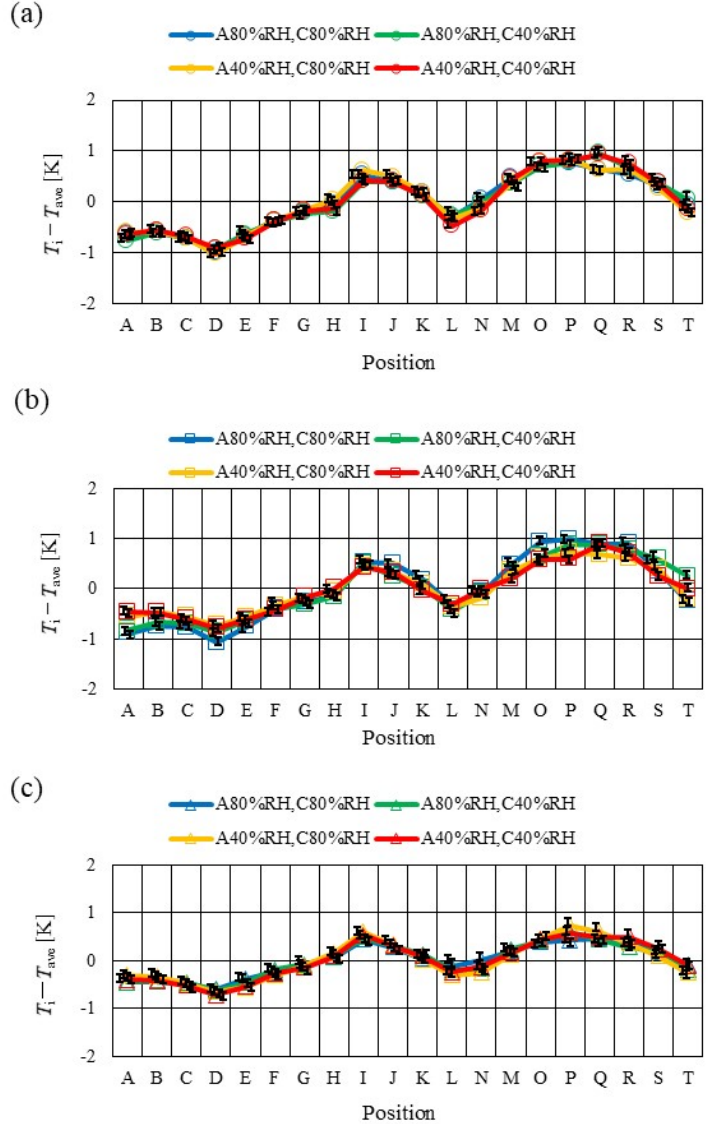
Figure 10. Comparison of the in-plane temperature distribution at the anode side among different RHs in the case of the separator thickness of 2.0 mm: ( a ) T init = 353 K; ( b ) T init = 363 K; ( c ) T init =